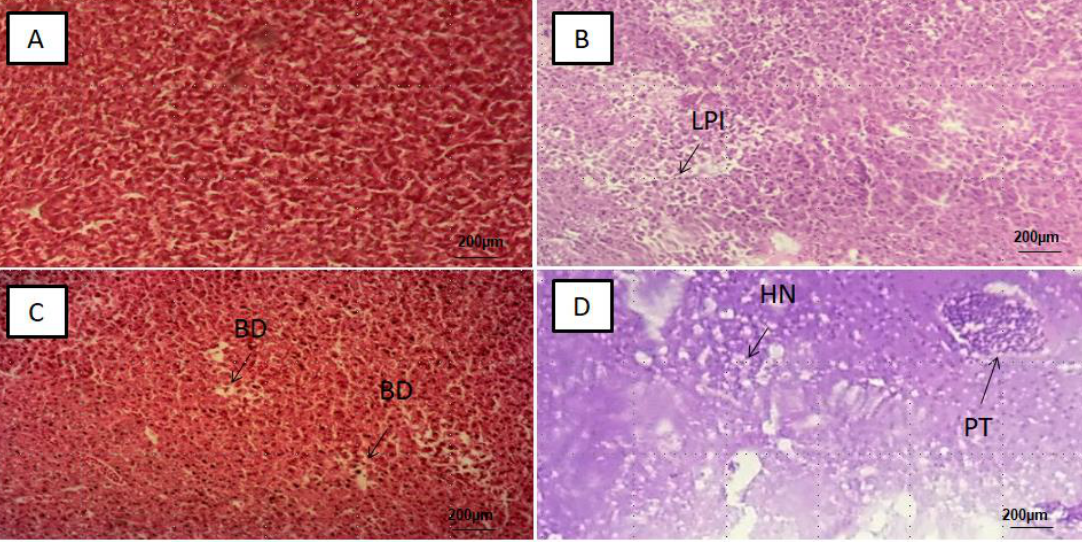
Figure 4. Representative photomicrograph of kidney tissue: ( A ) control group with normal tissue, ( B ) MP-LOW, ( C ) MP- MED, and ( D ) MP-HIGH, showing interstitial inflammation (II), interstitial oedema (IO) and tubular destruction (TD).